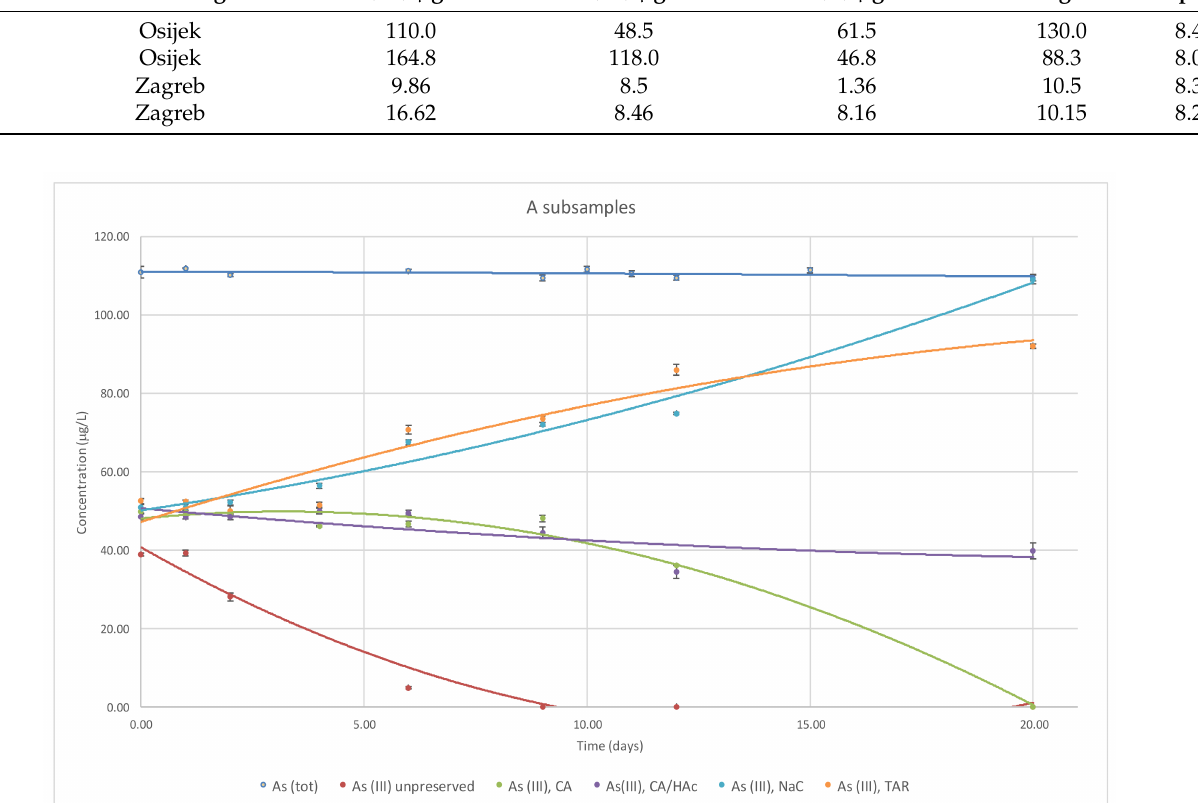
Table 2. Natural groundwater samples—the sampling site, arsenic, iron content and pH value of the samples. Sample